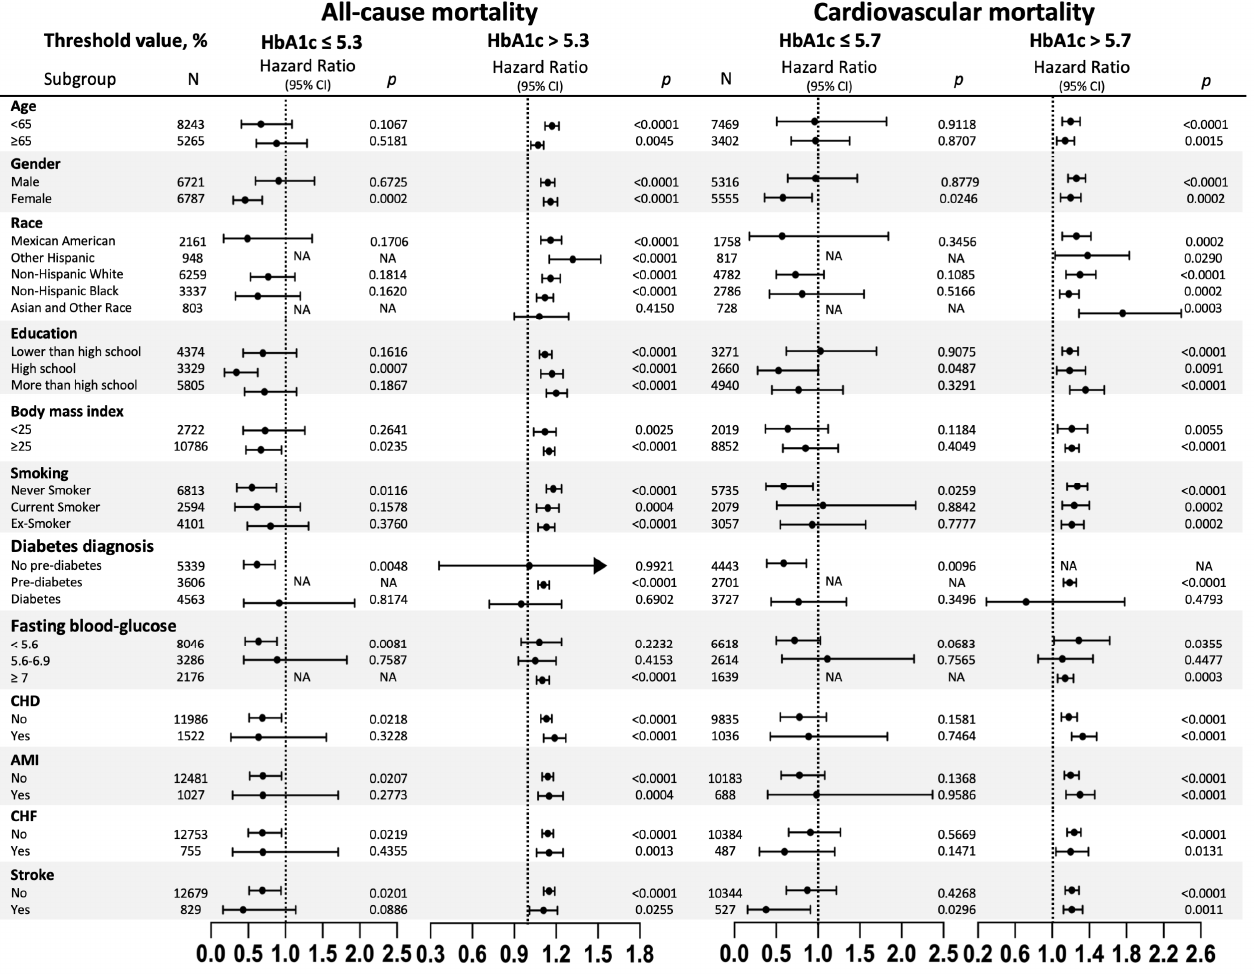
Figure 4. Subgroup analysis. HbA1c, glycated hemoglobin A1c; N, number; HR, hazard ratio; CI, confidence interval; Ex-Smoker, those who previously smoked but had currently stopped; CHD, coronary heart disease; AMI, acute myocardial infarction; CHF, chronic heart failure; NA, not available because of the small sample size. When analyzing a subgroup variable, age, gender, race, education, body mass index, smoking, CHD, AMI, CHF, stroke, creatinine, hemoglobin, triglycerides, total cholesterol, high-density lipoprotein cholesterol, antihypertensive drugs, hypoglycemic agents, aspirin, clopidogrel, and statin were all adjusted except the variable itself, and diabetes was not adjusted in cardiovascular mortality subgroup.